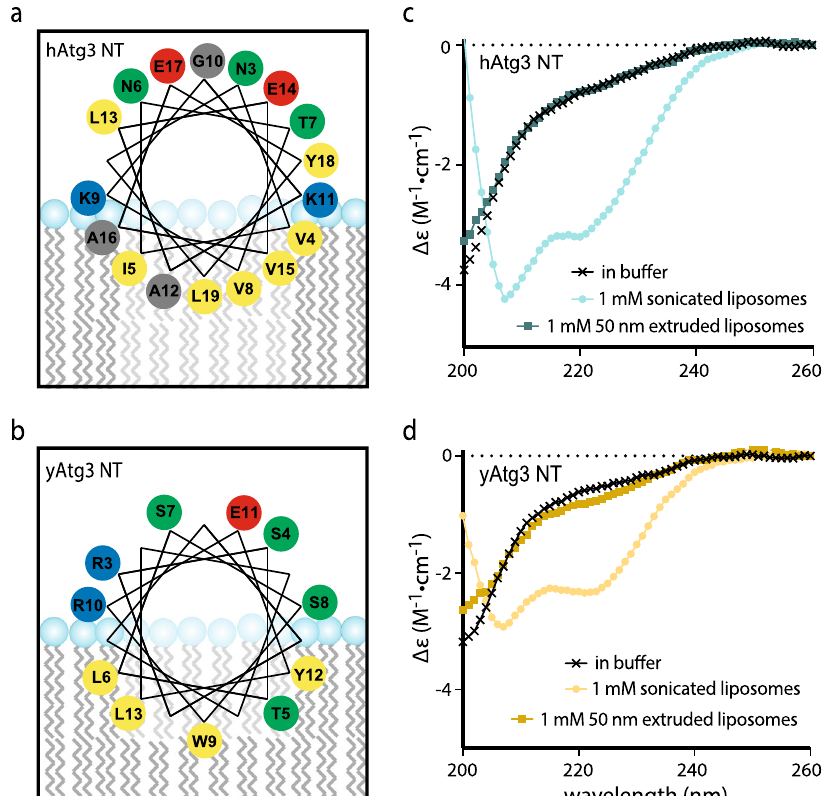
Fig. 2 Atg3 NTs have conserved membrane curvature sensitivity. a , b Helical wheel plots for hAtg3 and yAtg3 amphipathic helix. Residues are colored as in Fig. 1a. c , d CD spectra of hAtg3 NT and yAtg3 NT, respectively, in the absence and presence of 10% DOPG, 90% POPC sonicated, and 50 nm extruded liposomes. Average sizes for sonicated and 50 nm extruded liposomes, measured by dynamic light scattering, are 32 and 56 nm,